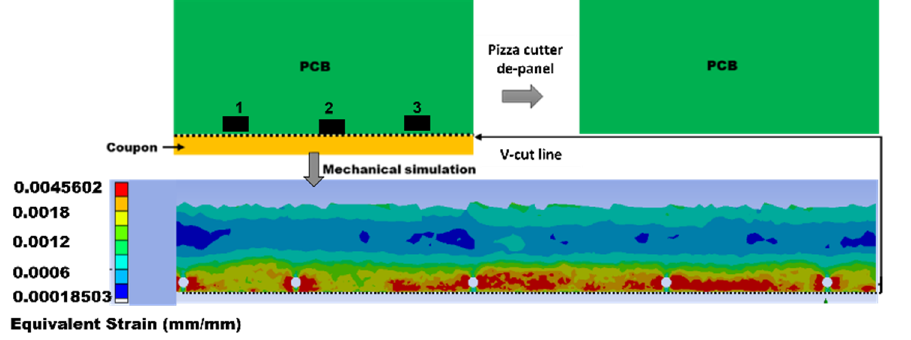
Figure 11. PCB de-panel process and mechanical simulation result. Locations 1, 2, and 3 show strain gauge measurement points.